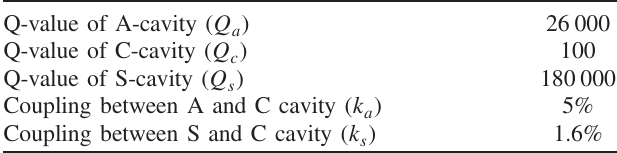
TABLE III. ARES cavity parameters used for the